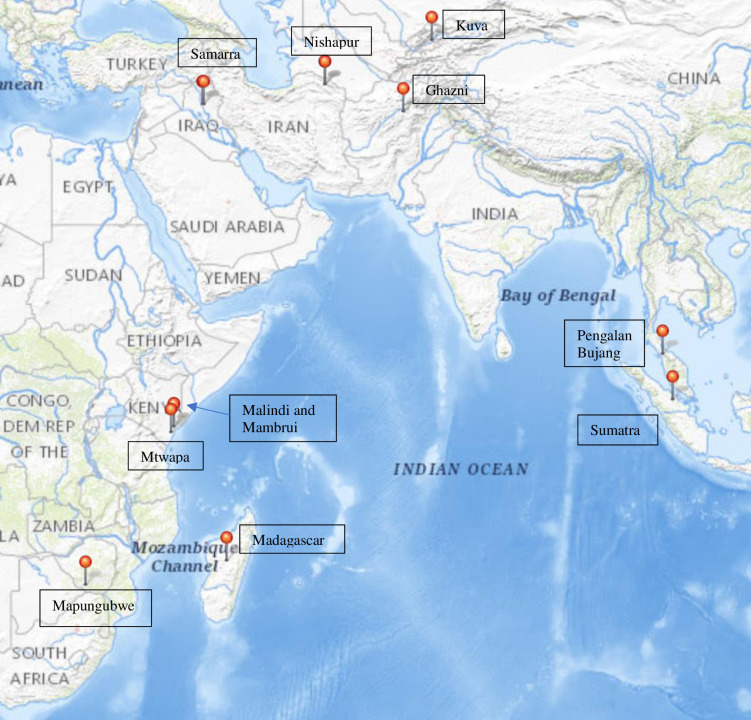
Locations of sites where v-Na-Al glass and low alumina soda plant ash glass have been found.V-Na-Al glass is found in: (1) Central Asia (9th– 14th centuries AD)—Kuva and Aksiket in Uzbekistan, Ghazni in Afghanistan; (2) Kenya—Malindi, Mambrui (15th– 16th centuries AD) and Mtwapa (10th– 17th centuries AD); (3) Madagascar (13th– 14th centuries AD); (4) southern Africa (13th– 15th centuries AD)—Mapungubwe, south Africa; (5) southeast Asia—Pengalan Bujang in Malaysia (12th– 13th centuries) and Sumatra in Indonesia (12th– 14th centuries AD). Low alumina soda glass is found in Nishapur in Iran (9th– 10th century AD) and Samarra (9th– 10th century AD) in Iraq. (Photograph) courtesy of the U.S. Geological Survey: https://viewer.nationalmap.gov/advanced-viewer/viewer/index.html?extent=-6583299.154%2C-4681356.4382%2C19578955.3912%2C6178816.5406%2C102100.